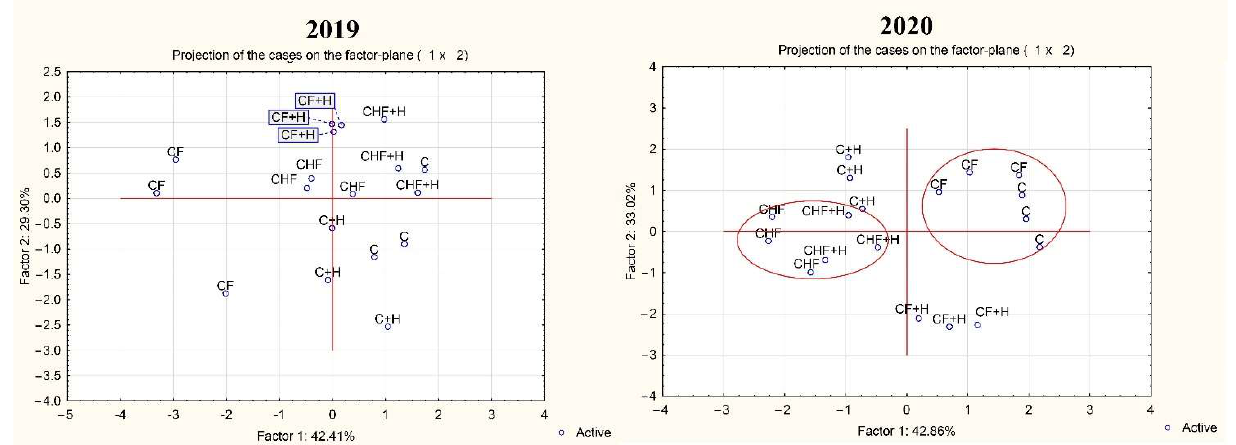
Figure 5. Position of the experimental variants in the plane of the first two principal components.